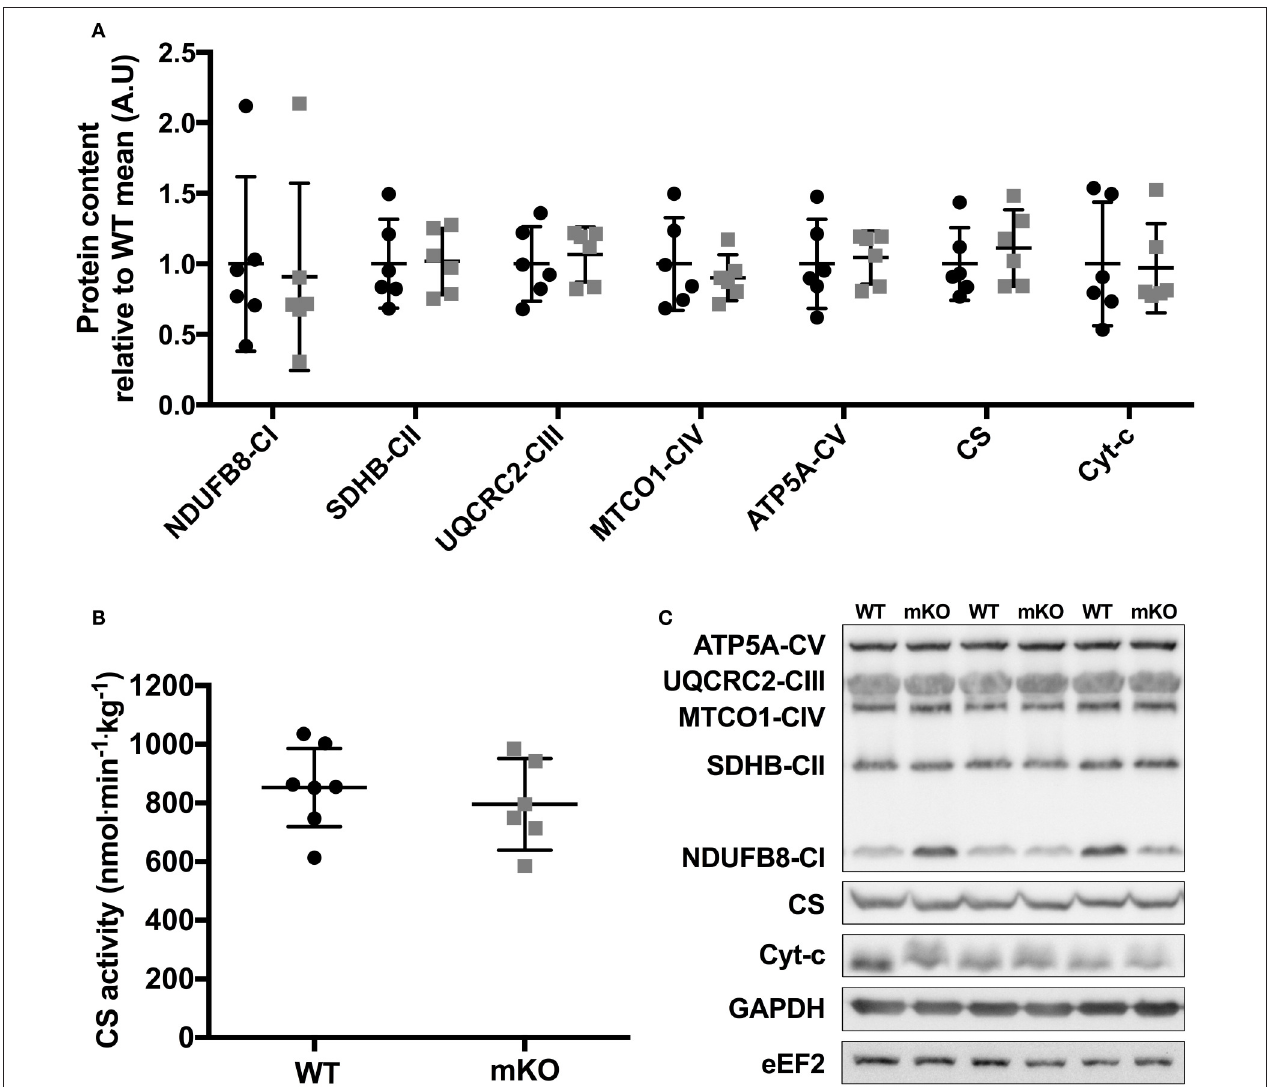
FIGURE 2 | Mitochondrial OXPHOS protein content and CS enzyme activity in p53 mKO (grey squares) and WT (black circles) mice. (A) WT and p53 mKO mice display similar protein content of mitochondrial enzymes (complexes I-V, CS, and Cyt-c) in gastrocnemius muscle ( p > 0.05; n = 6 per group). Similar data is apparent in triceps and quadriceps muscle (data not shown). (B) Similar CS enzyme activity in triceps muscle of p53 mKO and WT mice ( p > 0.05; n = 6–7 per group). Similar data is apparent in gastrocnemius and quadriceps muscle (data not shown). (C) Representative immunoblot images.